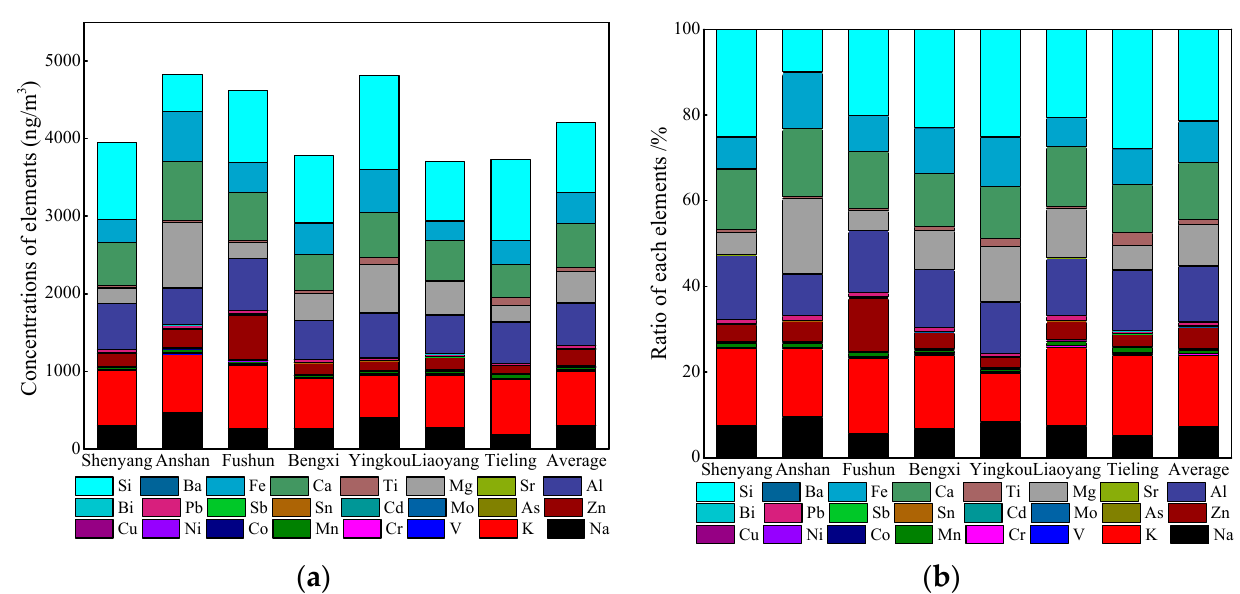
Figure 3. ( a ) Annual average concentrations of 24 elements in PM 2.5 at seven cities, ( b ) The average annual concentration of each element as a percentage of the total element concentration in PM 2.5 at seven cities.